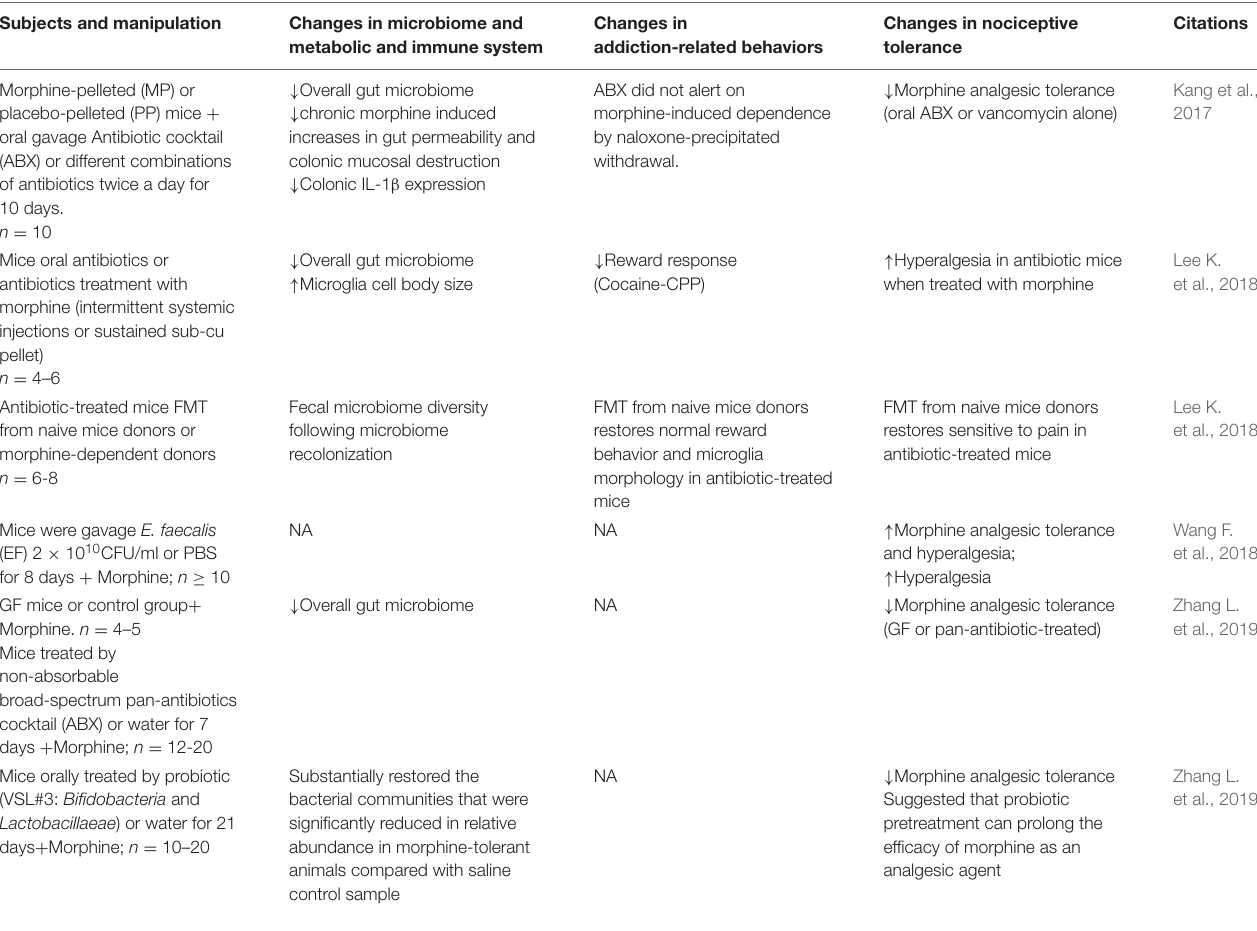
TABLE 5 | Interventions altering the gut microbiome in opioid-related disease. Subjects and